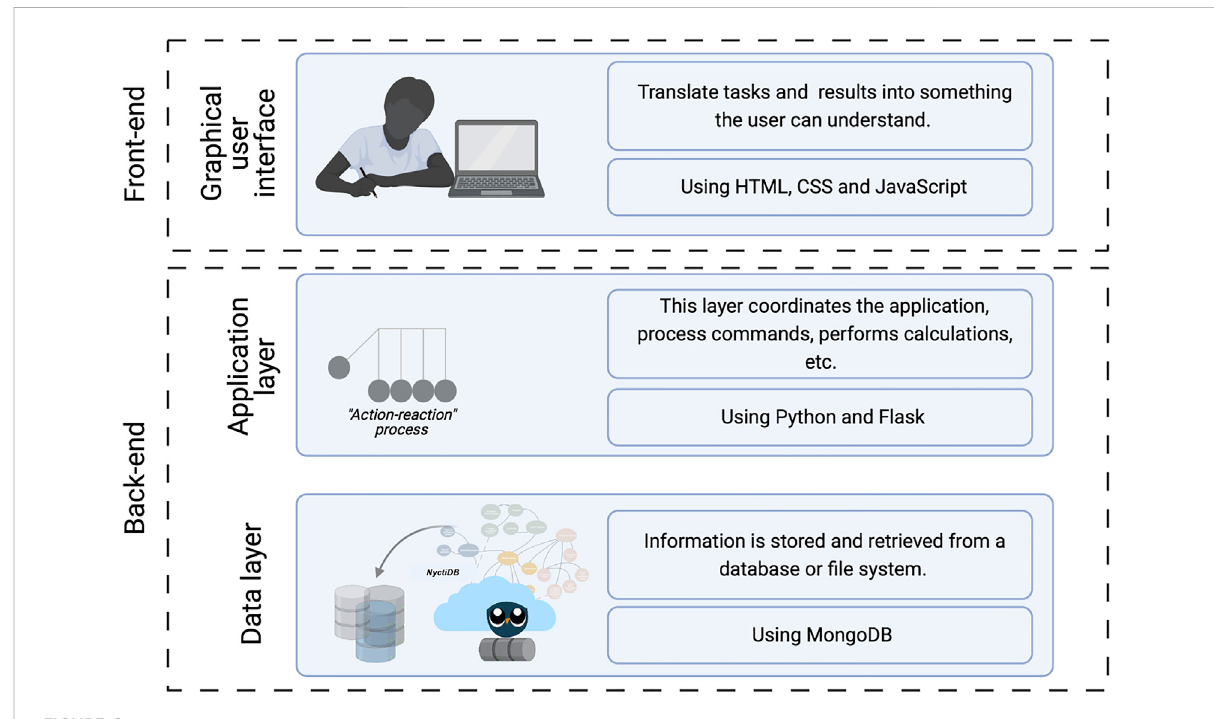
FIGURE 6 Three-tier software architecture of